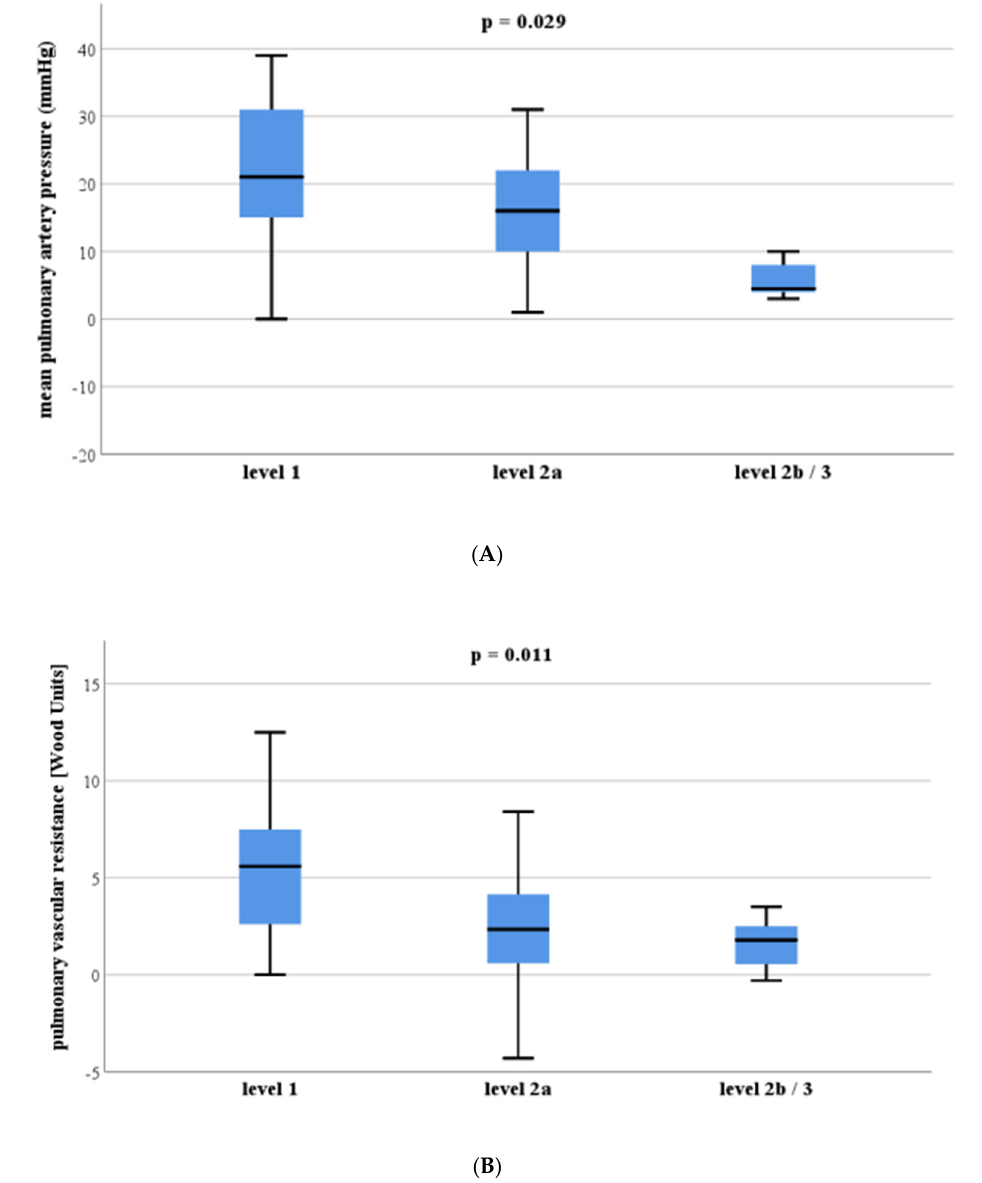
Figure 4. Boxplots indicate that the postoperative decrease in the mean pulmonary artery pressure (panel ( A )) and the pulmonary vascular resistance (panel ( B )) is significantly greater in chronic thromboembolic pulmonary hypertension (CTEPH) patients with involvement of the main pulmonary artery (level 1), compared to patients with involvement of the lobar arteries (level 2a) or involvement of the basal trunk of the lower lobe arteries or of segmental arteries (level 2b or level 3).